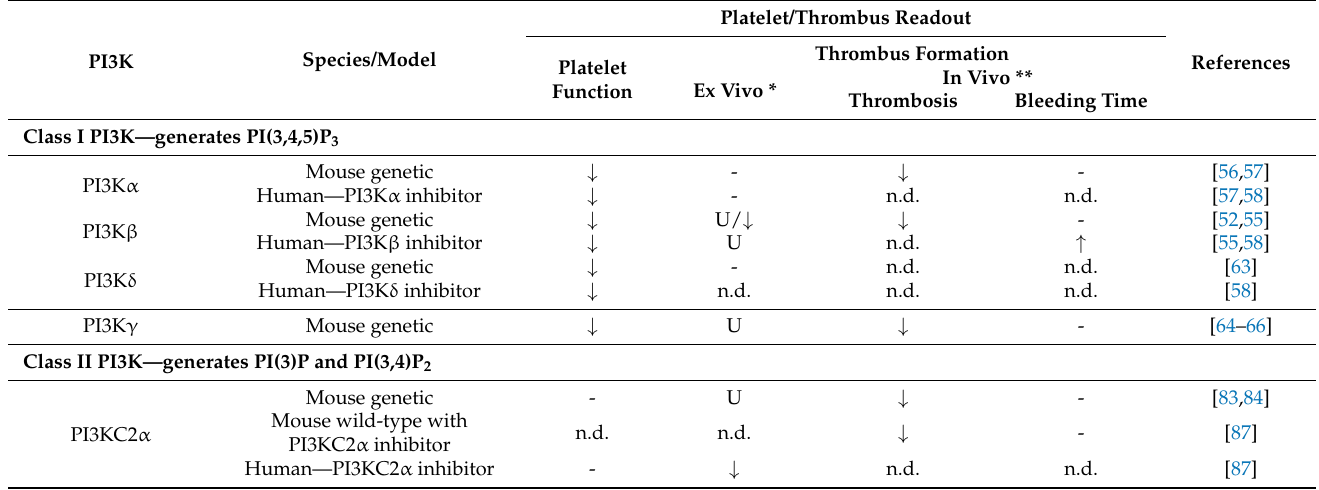
Table 1. Effects on platelet function and thrombus formation of targeting different PI3K